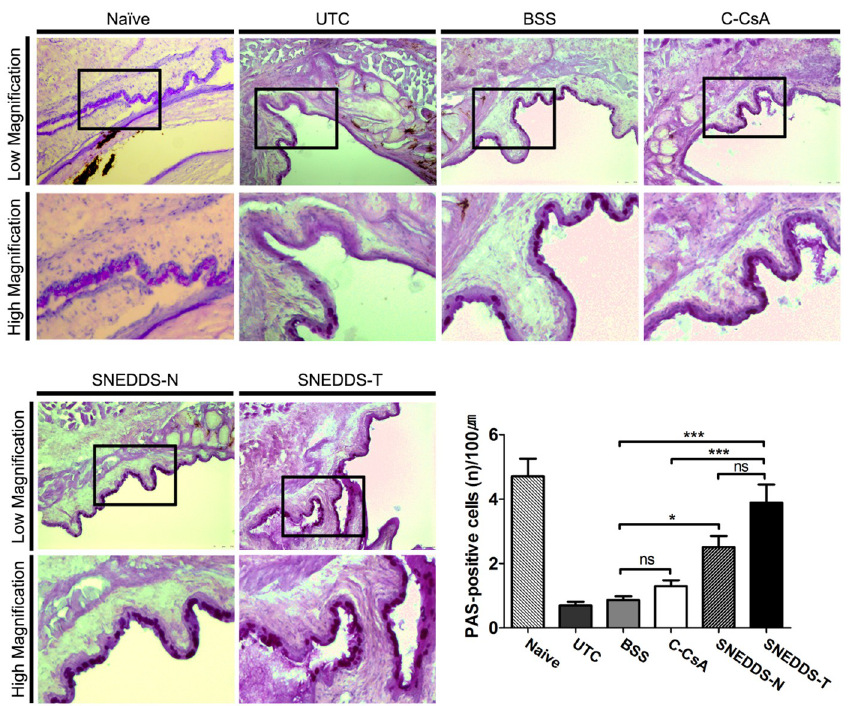
Fig 7. Mucin-containing goblet cells along the conjunctival fornices were visualised by PAS staining in the untreated control, BSS-treated, C-CsA-treated, SNEDDS-N-treated and SNEDDS-T-treated subgroups, and mean numbers of PAS + cells in each subgroup were quantified (n = 5). Data are expressed as mean ± SD. � P < 0.05, �� P < 0.01, ��� P < 0.001 by independent t-test.